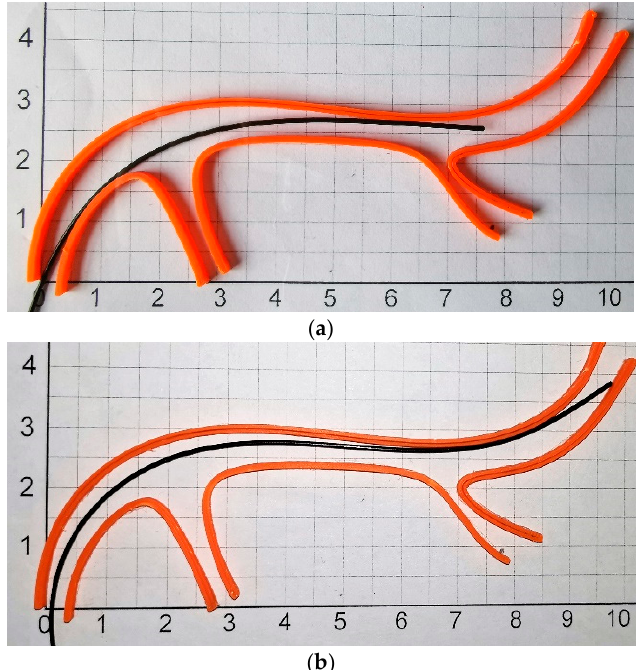
Figure 12. Two positions during the advancement of the guidewire: ( a ) Position I; ( b ) Position II.